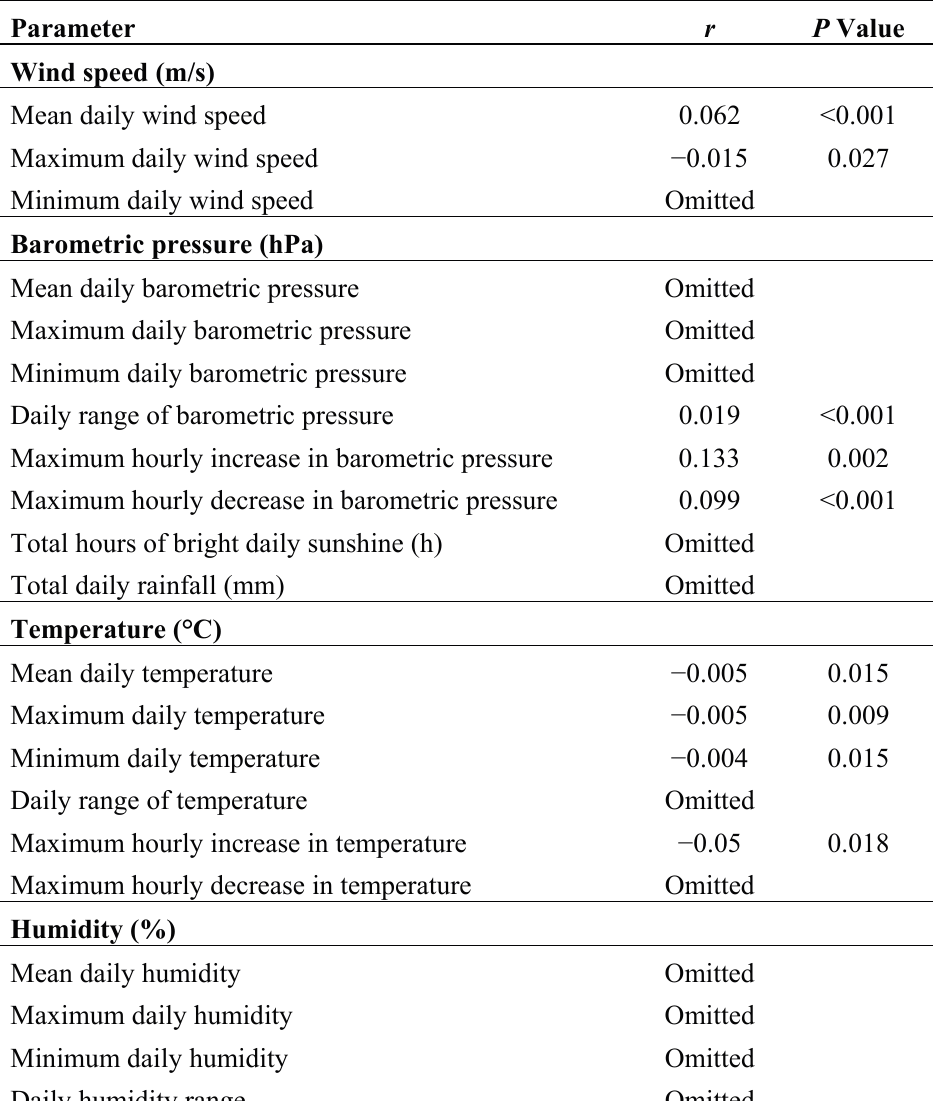
Table 2. Significant cross correlations with acute phase of chronic periodontitis without direct-triggered